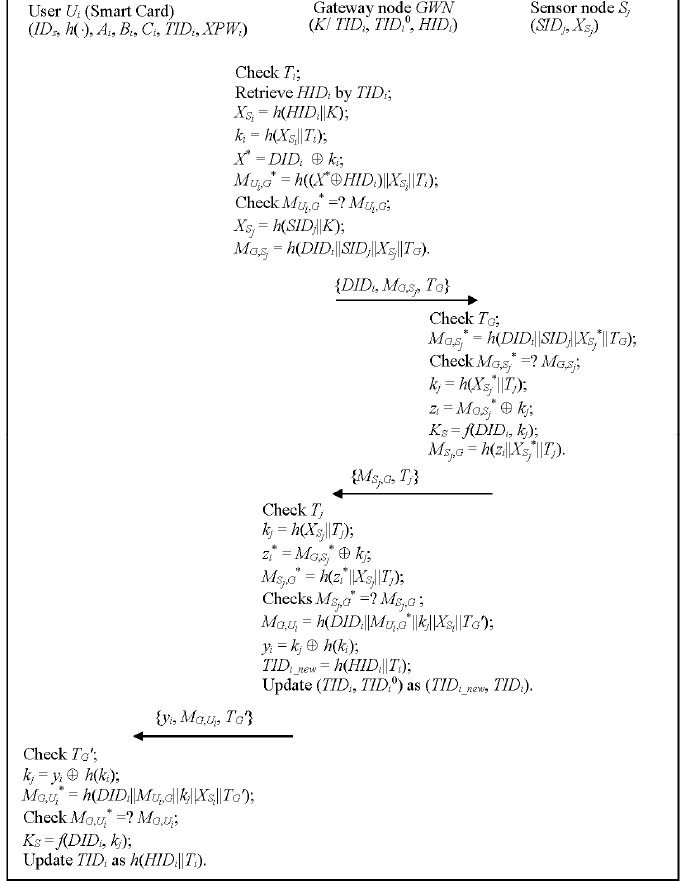
Figure 3. The authentication and key agreement phase of the proposed scheme for WSNs.